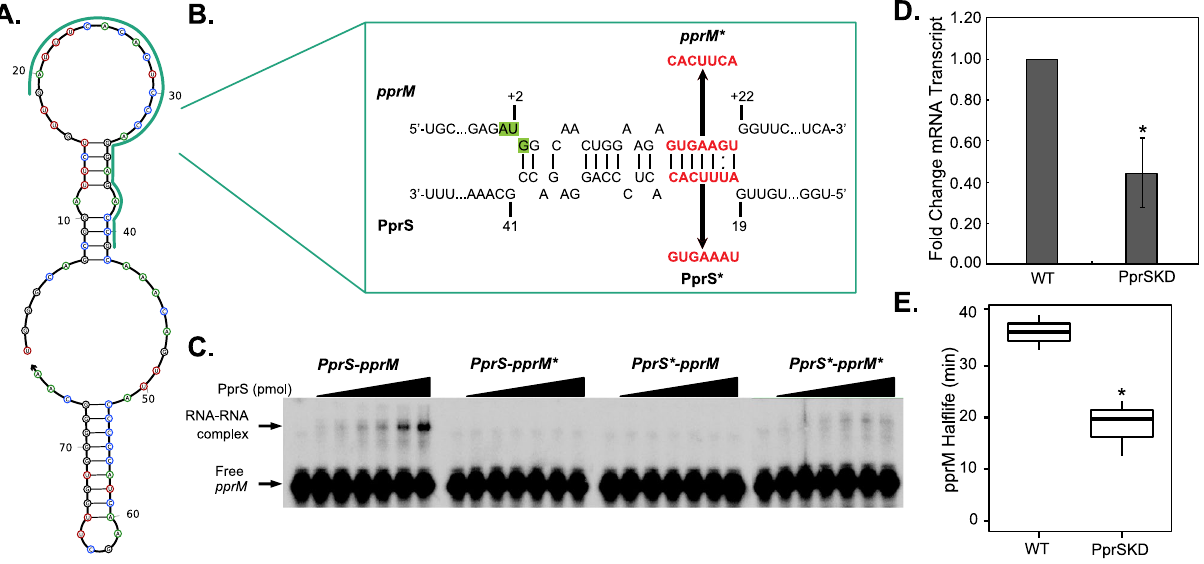
Figure 3. PprS binding stabilizes pprM transcript. ( A ) Predicted structure of PprS (from NUPACK 61 ) with region of PprS- pprM interaction highlighted. ( B ) Prediction of PprS binding to pprM by IntaRNA with mutation of pprM -PprS interaction site shown in red. Nucleotide positions are given for the revised start codon of pprM . (If utilize the start codon annotated in the D. radiodurans genome, the predicted binding site is from + 149 to + 163 nt after the start codon). ( C ) Representative EMSA (n = 2–3) of PprS binding to pprM transcript in vitro. In each lane, 1 pmol of radiolabeled pprM mRNA fragment (− 33 to + 100 nt relative to start codon) was incubated with 0–100 pmol of PprS sRNA. K d ’s were determined for the PprS- pprM EMSA to be 39.59 ± 15.56 pmol and 45.59 ± 1.84 pmol for the complemented mutations (PprS*- pprM* ). ( D ) pprM transcripts levels were determined in unstressed conditions by RT-qPCR analysis. Bars represent the fold changes in gene expression compared to WT. Error bars represent standard deviation of triplicate biological samples. Difference in pprM transcript level between strains is significant by two-tailed Student’s t-test ( p -value < 0.05). ( E ) Boxplot of pprM halflife in WT versus PprSKD strains calculated from Northern blot analysis. Difference between half-lives (36.46 ± 3.37 min for R1 versus 18.48 ± 5.37 min) was significant by two-tailed Student’s t-test ( p -value < 0.05) from biological triplicates from two independent experiments (representative Northern blot presented in Figs. S8 and